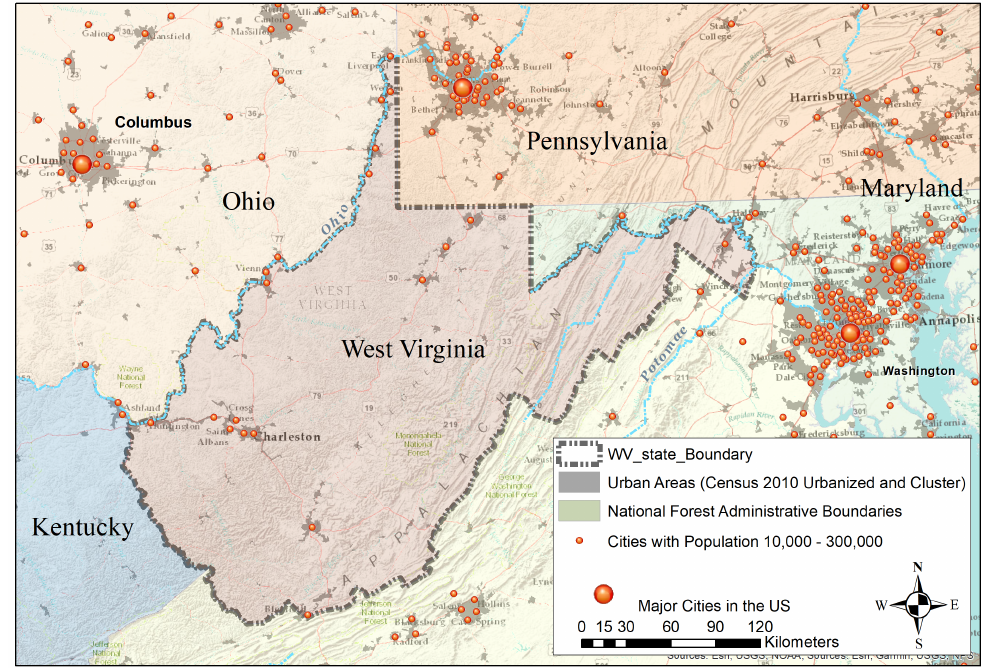
Figure 3. West Virginia State (Data Source